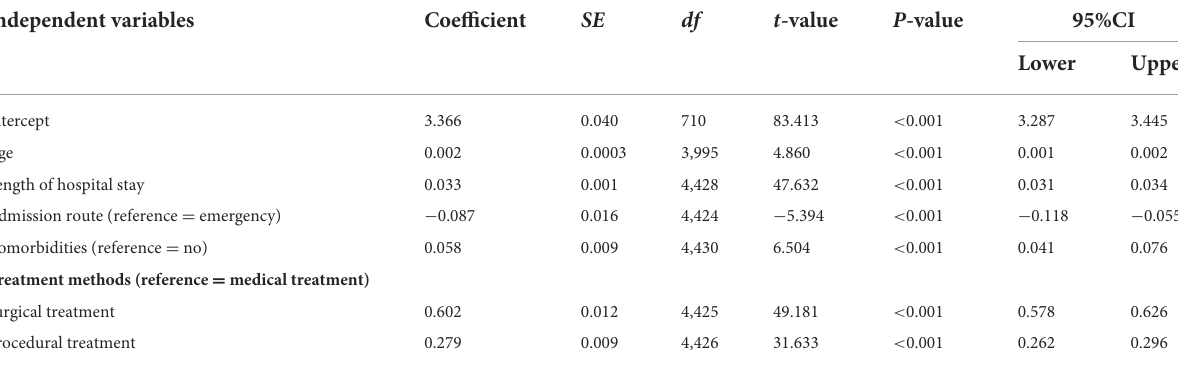
TABLE 3 Summary of the multivariable regression analyses for hospital expenses in CD patients. Independent